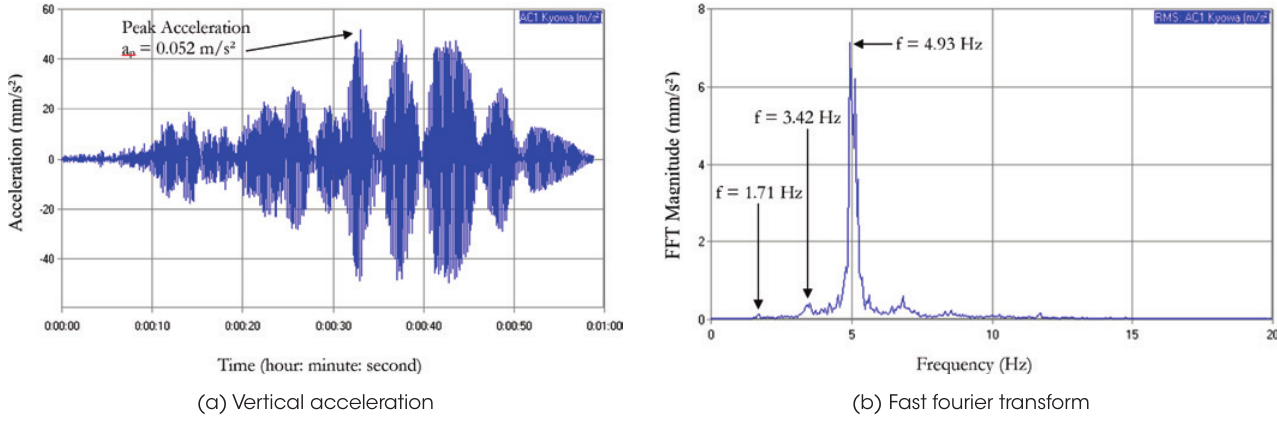
(a) Vertical acceleration Figure 18 Dynamic structural response of the footbridge due to slow walking of 8 people (f